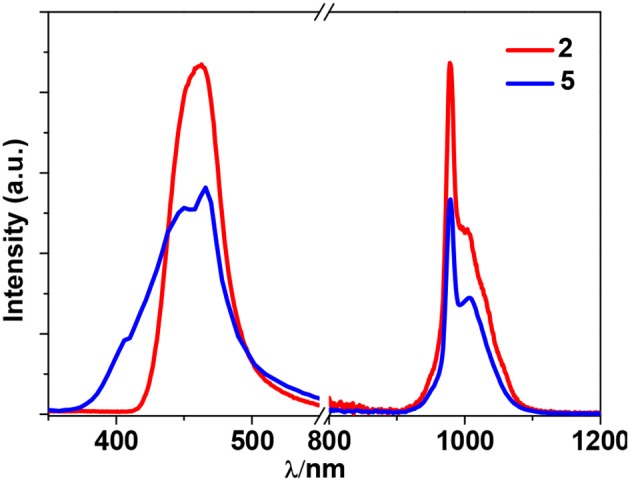
Excitation and emission spectra for 2 and 5 in CH3CN.